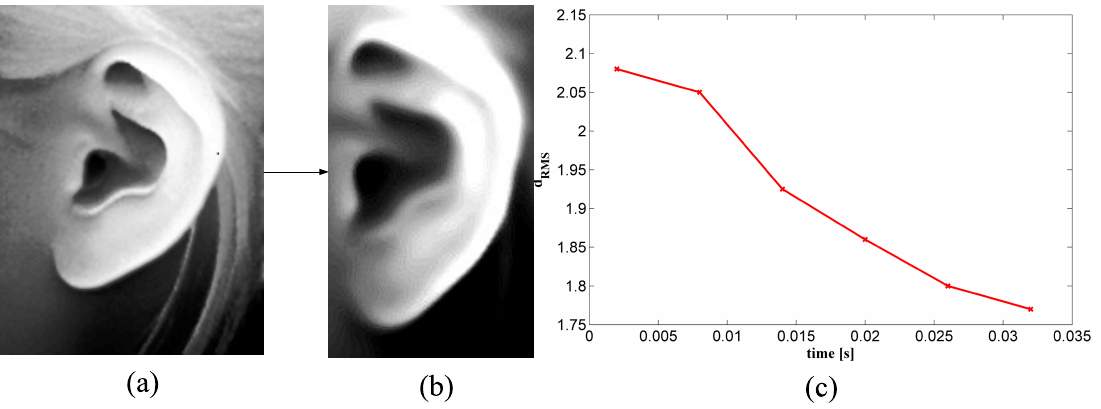
Figure 5. Ear normalization: ( a ) The coarsely segmented ear; ( b ) The normalized ear; ( c ) The time-error curve of five